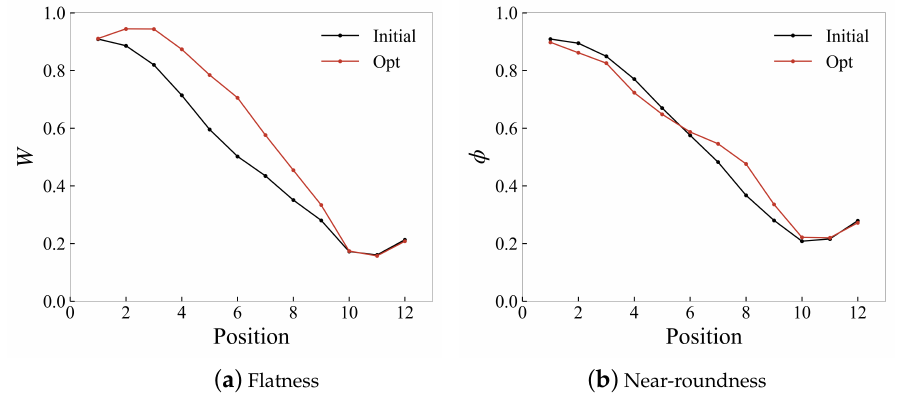
Figure 14. Comparison of section parameters.